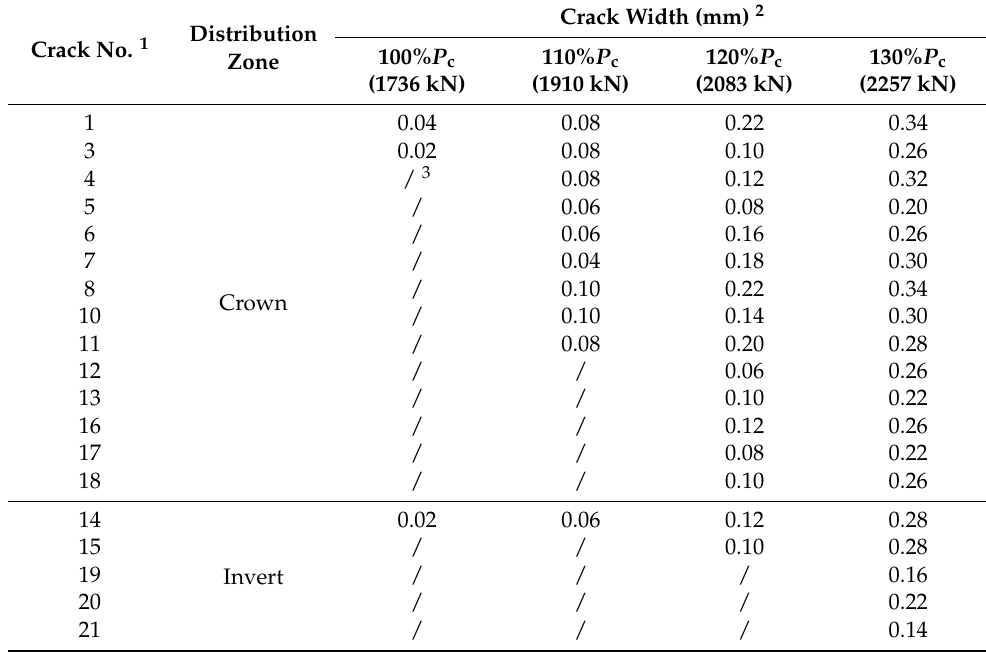
Figure 9. Diagram for distribution zone of cracks on the inner surface of pipe concrete. Table 6. The width and distribution zone of concrete cracks.